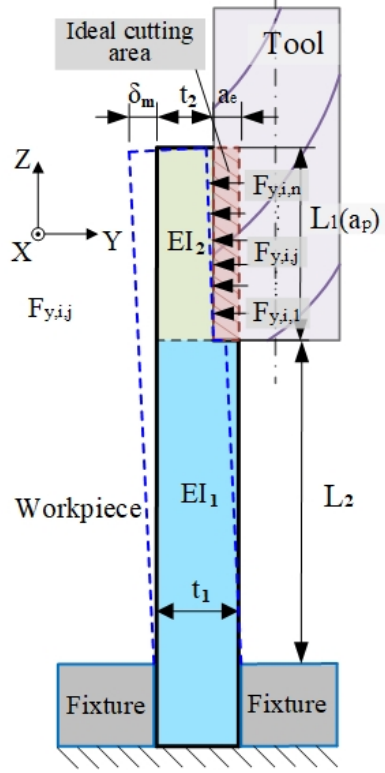
Figure 2. Beam model of the workpiece [37].